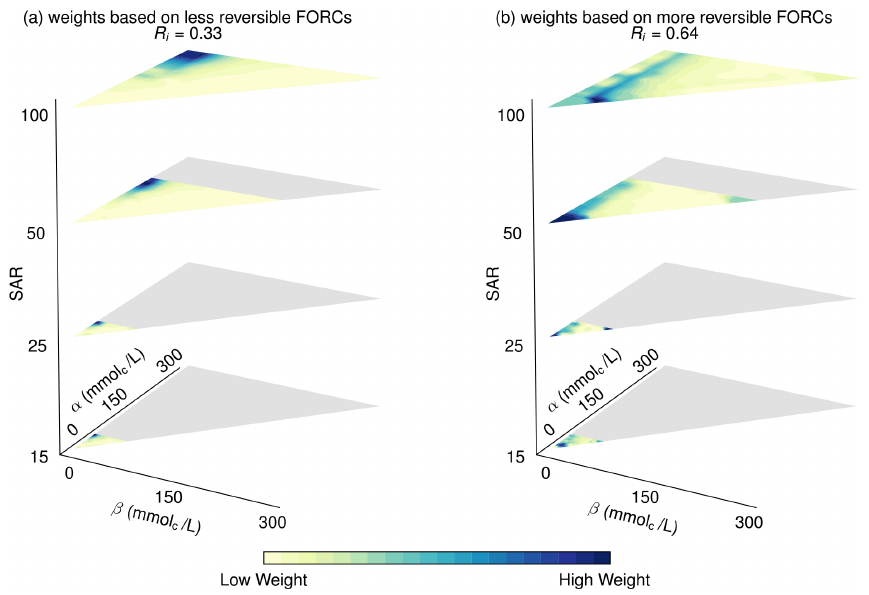
Figure 6. Potential weight functions, showing low (a) and high (b) levels of reversibility, are constructed based on the degradation exper- iments in McNeal and Coleman (1966). (a) Weight functions based on less reversible FORCs; reversibility index is R i = 0 . 33. (b) Weight functions based on more reversible FORCs; reversibility index is R i = 0 .